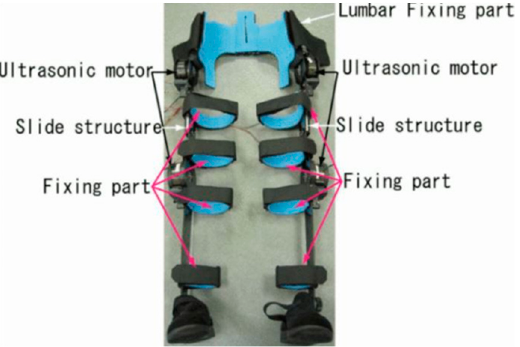
Figure 5. Ultrasonic Motor-Powered Assisted Suit System [17]. Reprinted with permission from IEEE. License Number: 5383601211803; license date: 7 September 2022.